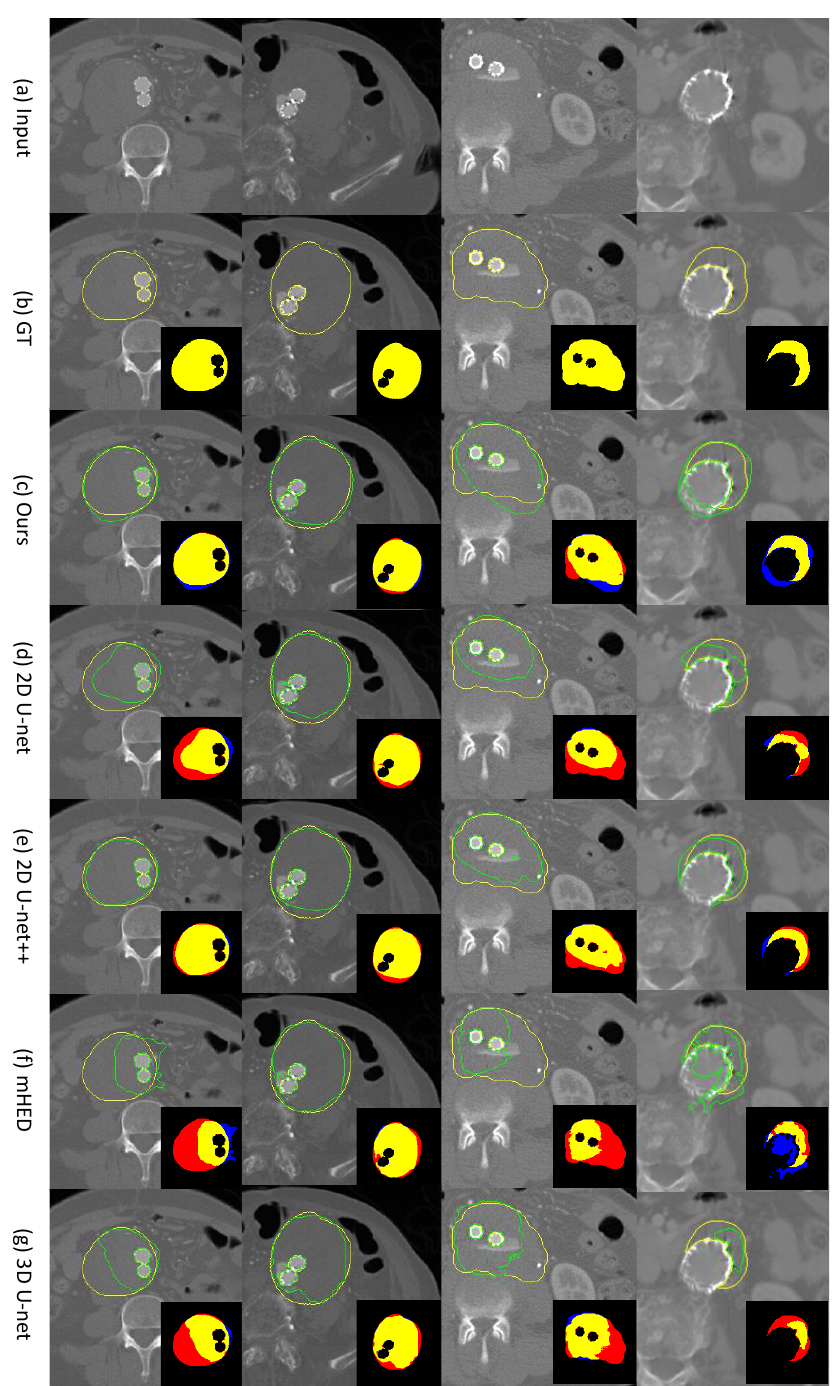
Figure 3. Thrombus ROI segmentation results comparison using four patient studies (each column representing a study). Seven rows represent: ( a ) row image; ( b ) GT mask; ( c ) segmentation result from our Bi-CLSTM method; ( d ) 2D U-net; ( e ) 2D U-net++; ( f ) mHED; ( g ) 3D U-net. In full-scale images, the yellow line denotes the GT; and the green line is the predicted mask from different methods. In cropped insets, the yellow color indicates true positive voxels; the red color is false negative; and the blue color is false